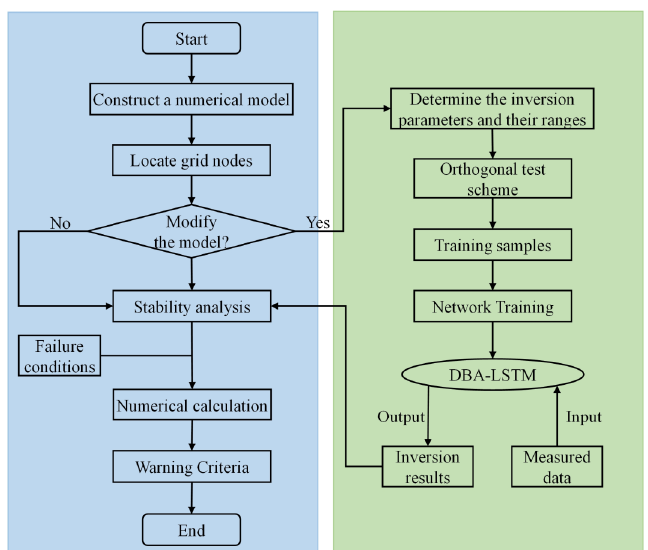
Figure 6. Threshold calculation